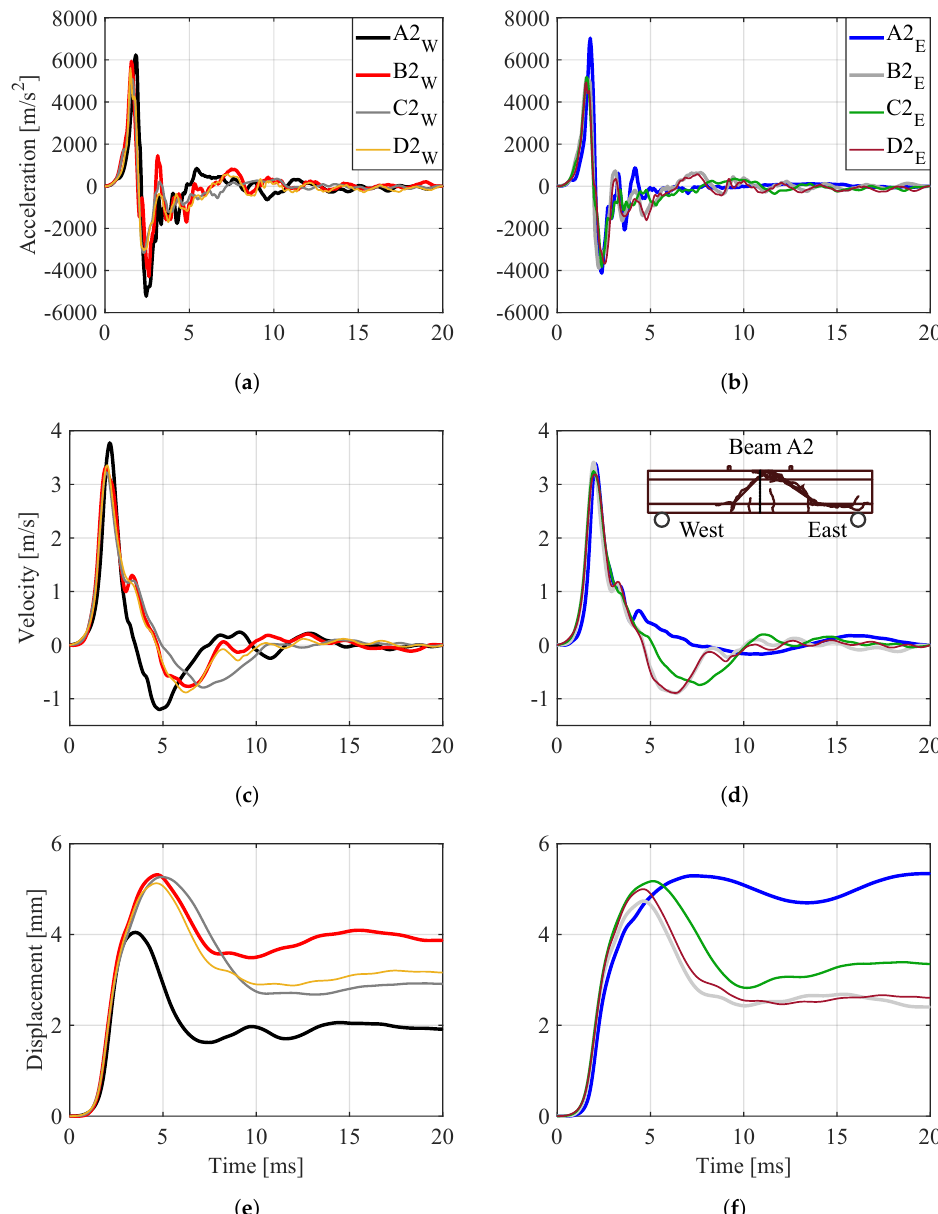
Figure 12. ( a ) Signal-processed acceleration at the west accelerometer for Beams A2–D2 during the first impact test; ( b ) acceleration at the east accelerometer for A2–D2 during the first impact test; ( c ) integrated velocity at the west accelerometer for A2–D2; ( d ) integrated velocity at the east accelerometer for A2–D2; ( e ) integrated displacement at the west accelerometer for A2–D2; and ( f ) integrated displacement at the east accelerometer for A2–D2. The signals for Beams B2–D2 during the second and fifth impact tests are presented in Figure 13. The response in terms of velocity and displacement of Beam D1 were similar during the second and fifth impact test. This shows that the response for dynamically flexure-dominated beams does not change with sequential impacts. The response of Beam B2, which showed a hybrid response, changed drastically between the second and fifth test. Low-frequency oscillations occurred for Beam B2 in (d), indicating a high degree of damage to the beam. Beam C2 showed large permanent deformation after the second impact in (e) due to the global flexural shear crack